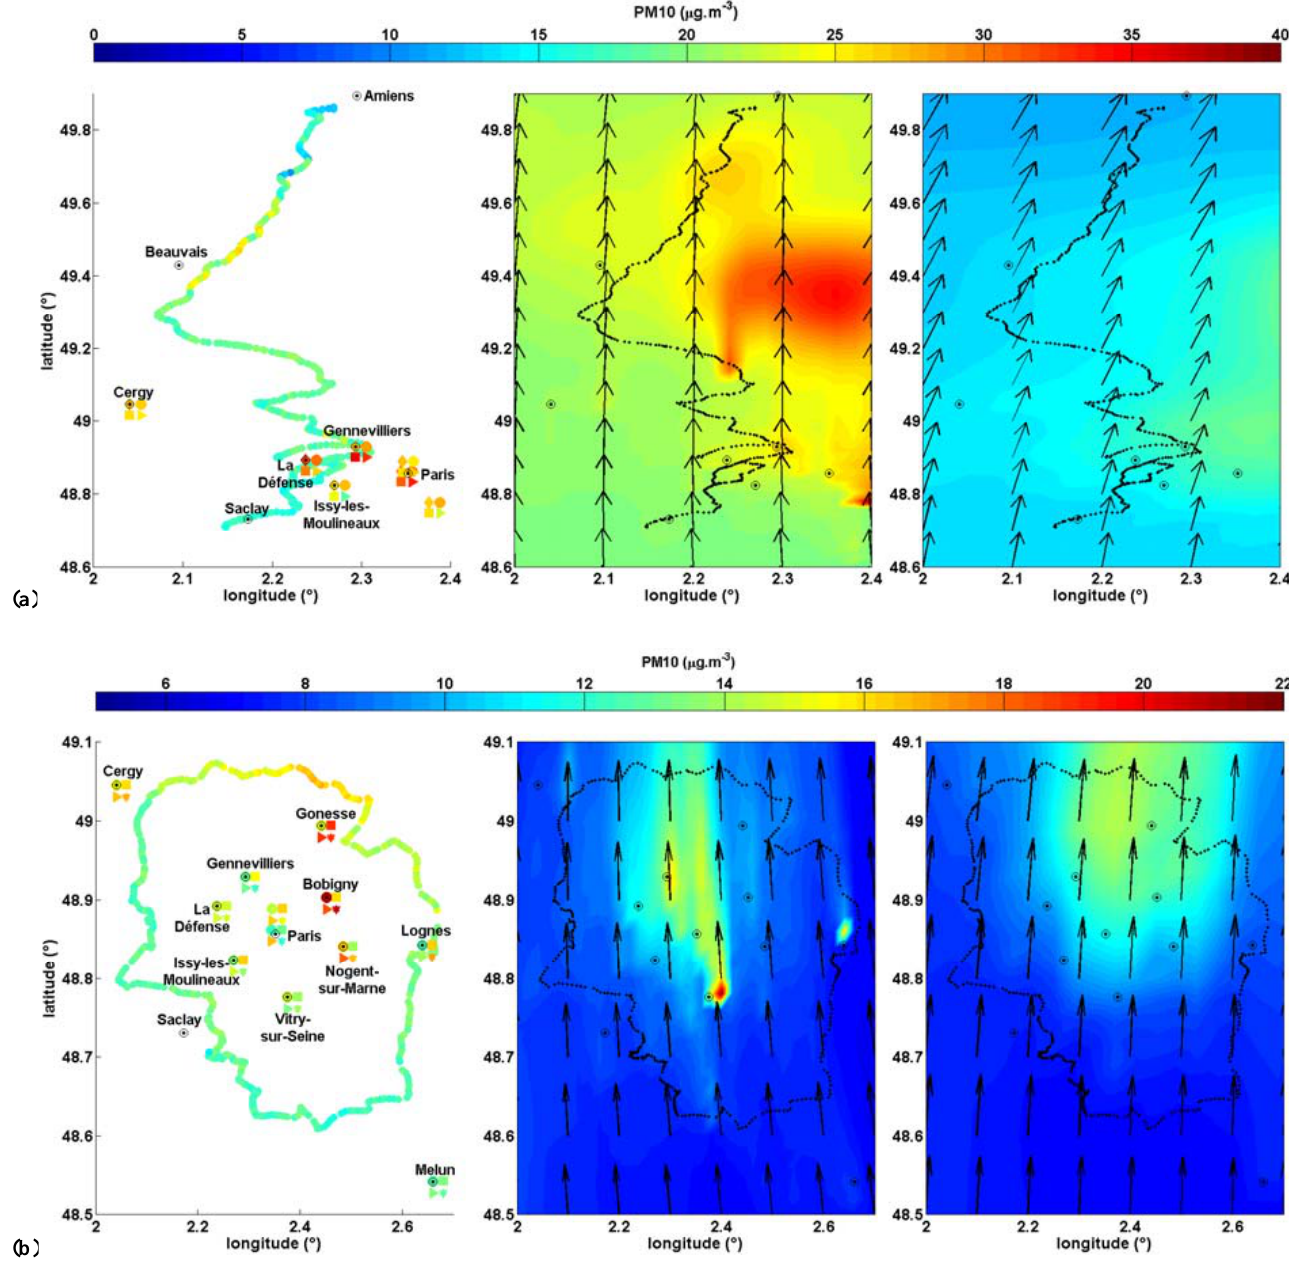
Fig. 5. Same as Fig. 3 on 16 (a) and 26 (b)